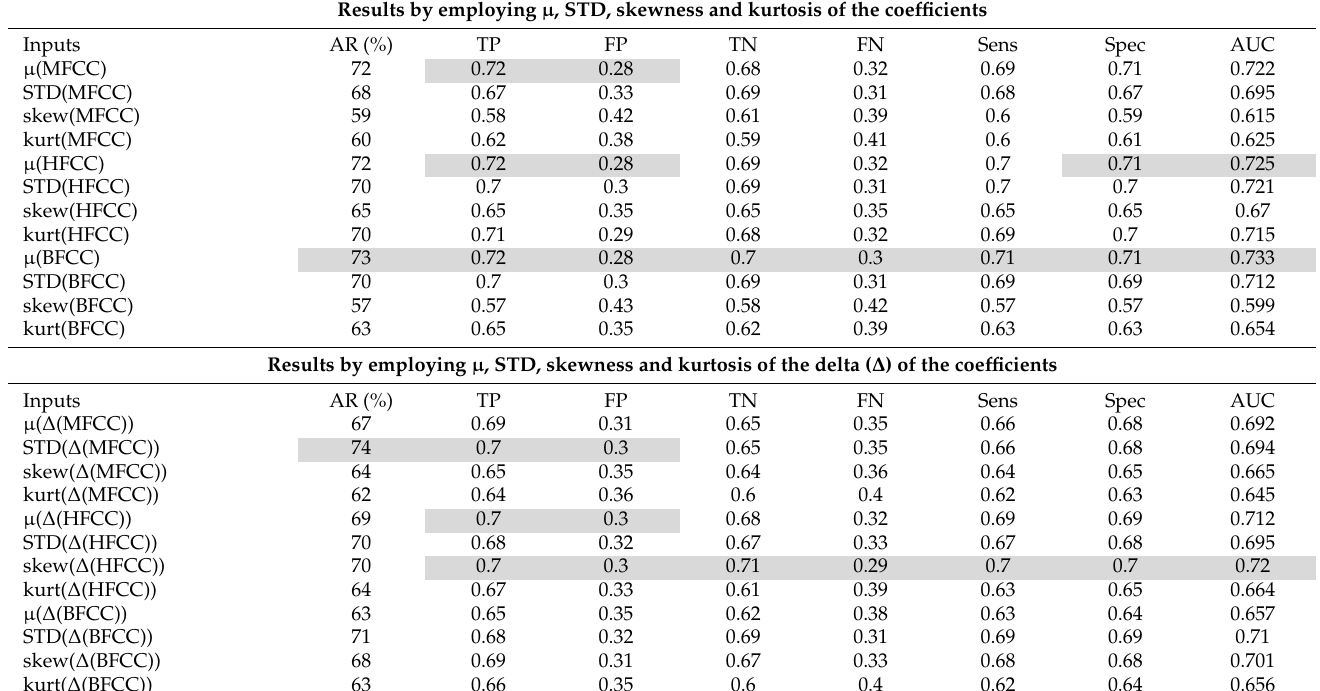
Table 2. Evaluation of the RF model with MFCC, HFCC and BFCC filters, by individually employing the first four moments of their distributions (mean- µ , standard deviation-STD, skewness-skew and kurtosis-kurt), their ∆ and their ∆∆ . 10-cross-validation with 20,000 laughs (18,000 training and 2000 test in 10 epochs). AR, accuracy rate; TP, true positive; FP, false positive; TN, true negative; FN, false negative; Sens, sensitivity; Spec, specificity. Best performance per column is highlighted in bold. Results by employing µ , STD, skewness and kurtosis of the coefficients